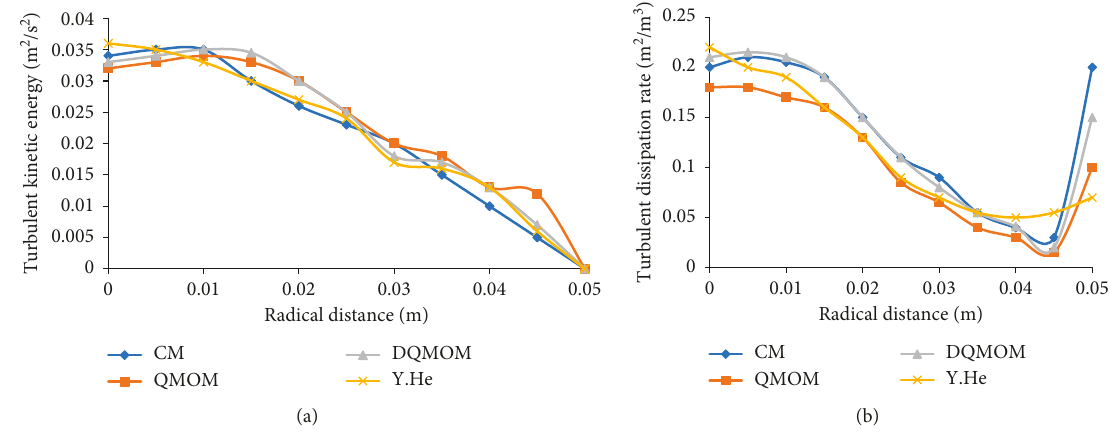
Figure 10: The mixture phase turbulent performance along the radical distance h �